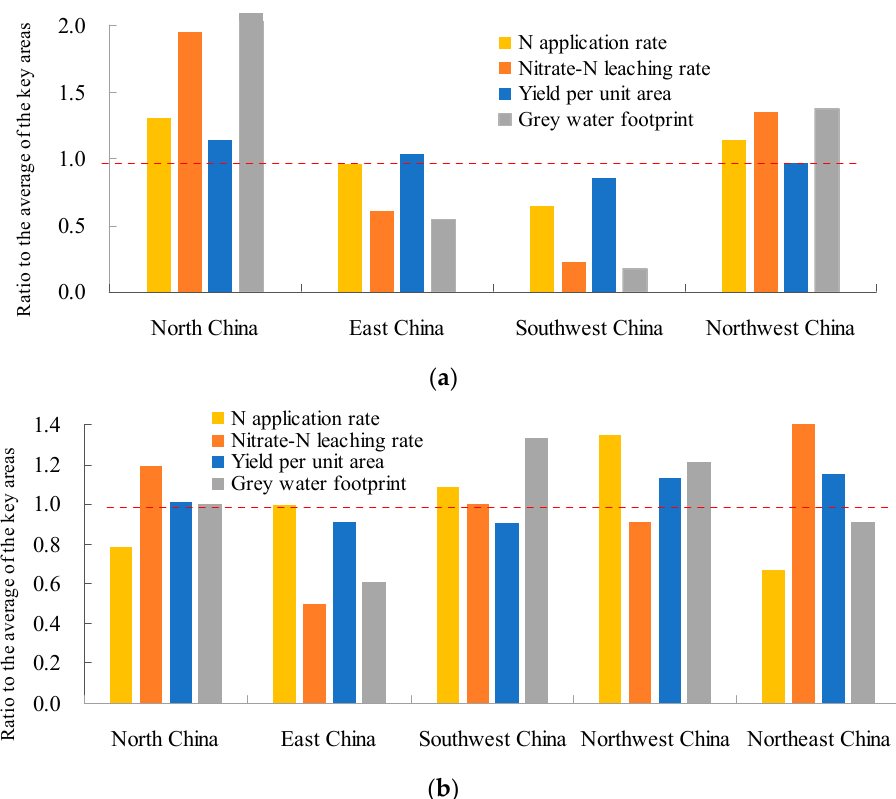
Figure 5. Ratio of WFgrey of wheat ( a ) and maize ( b ) in each division to the key divisional average, and the factors affecting it.